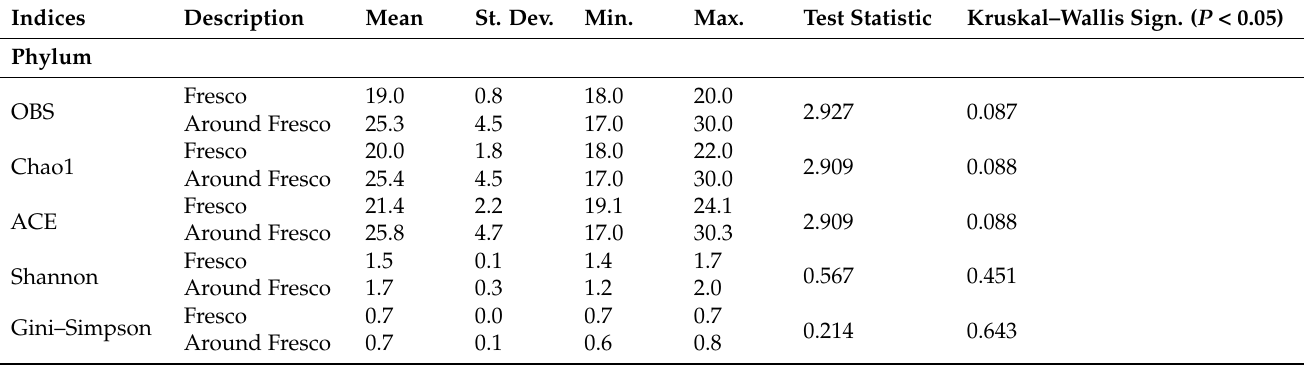
Table 1. Alpha diversity within the analyzed samples from fresco and around it (average values) and presented at the phylum, family, genus, and ASV taxa